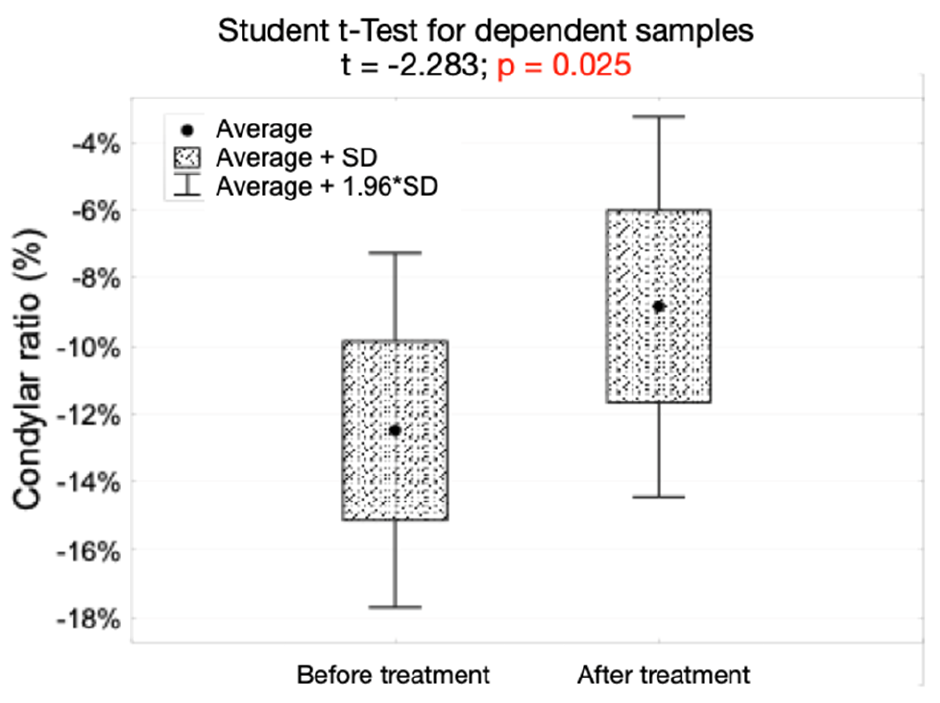
Figure 6. The values of condylar ratio before and after the end of the treatment, as well as the results of Student t -test for dependent samples in the study group.